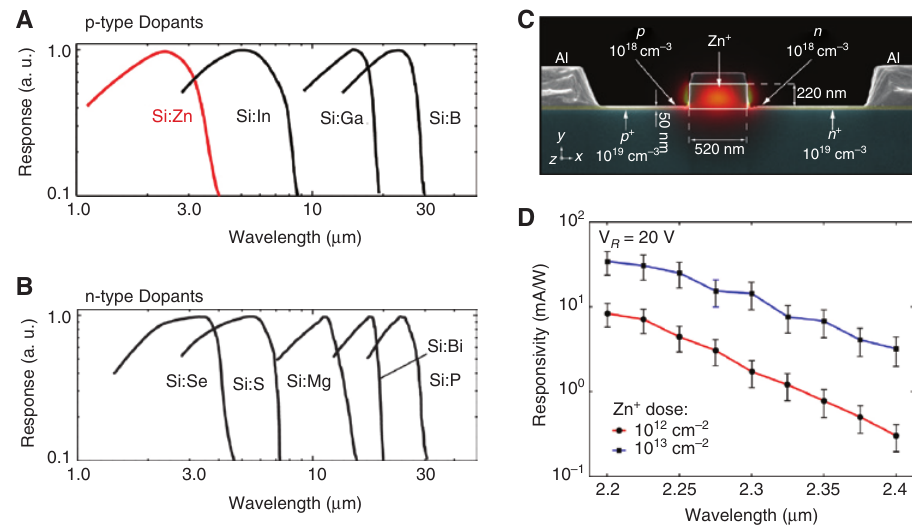
Figure 14: Extrinsic silicon for mid-IR detection. (A, B) Normalized spectral response of bulk extrinsic silicon photoconductors for (A) p-type and (B) n-type dopants; (C) false color cross- sectional SEM image of a Zn-implanted SOI detector with TE mode intensity at 2.3 μ m superimposed, photoelectrons generated through Zn dopant level absorption are collected by the lateral p-i-n diode structure; (D) spectral response of the detector [182] (© 2014 Optical Society of